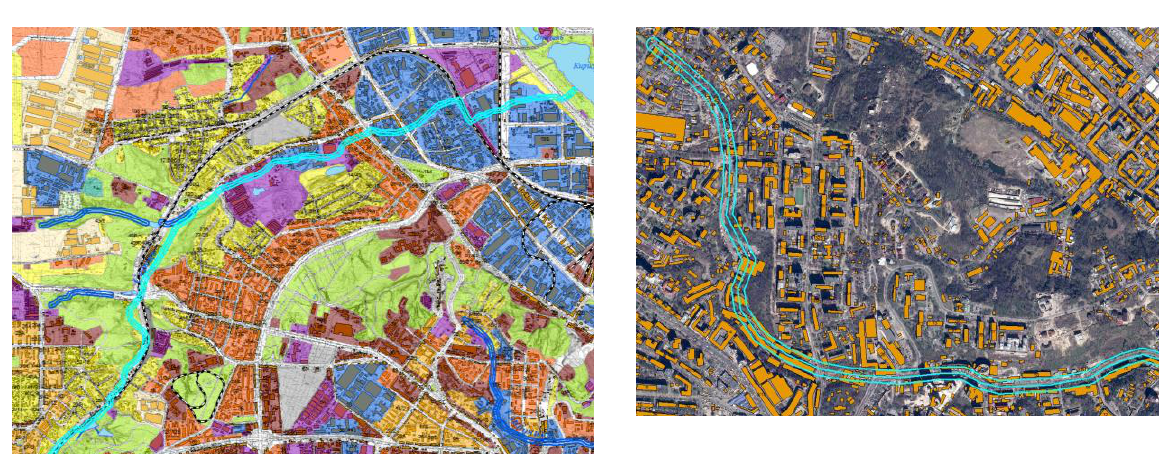
Similarly, the railway passing in the valley of the Lybid river duplicates the channel almost in its entire length, and the urbanization of the river is 100% (Fig. 3).